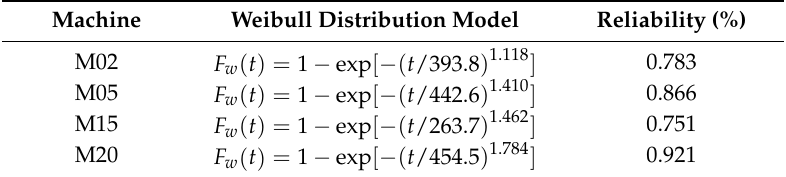
Table 4. Reliability of the most critical machines during the preventive maintenance period.